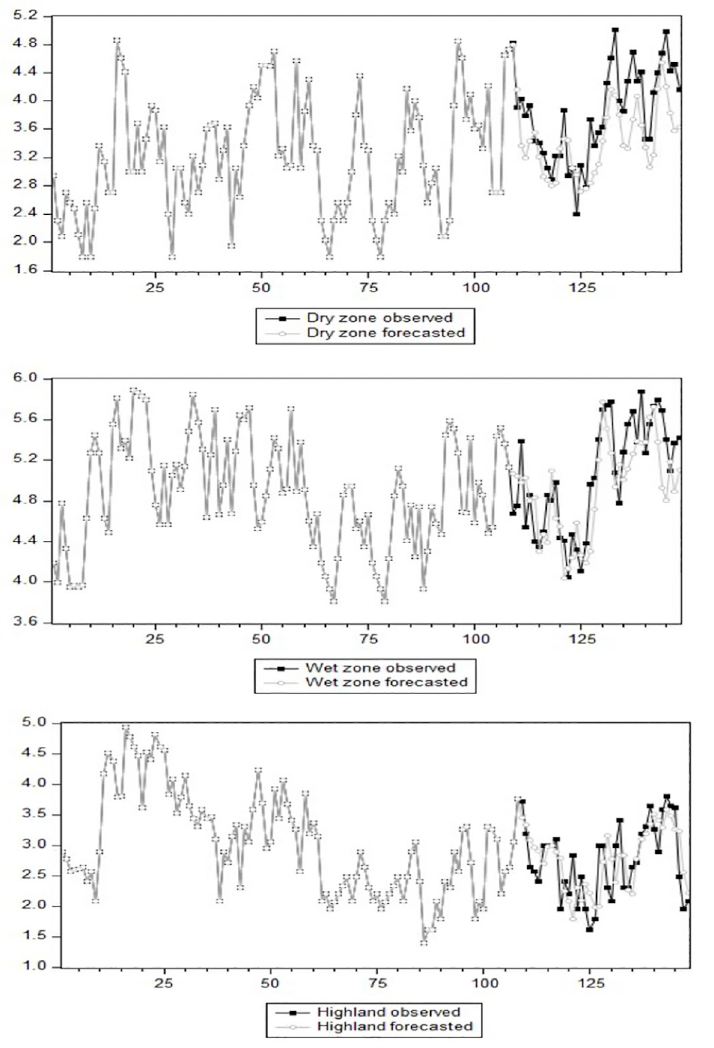
Fig 7. Natural log–transformed observed and forecasted values of the leptospirosis cases for the three climate zones.